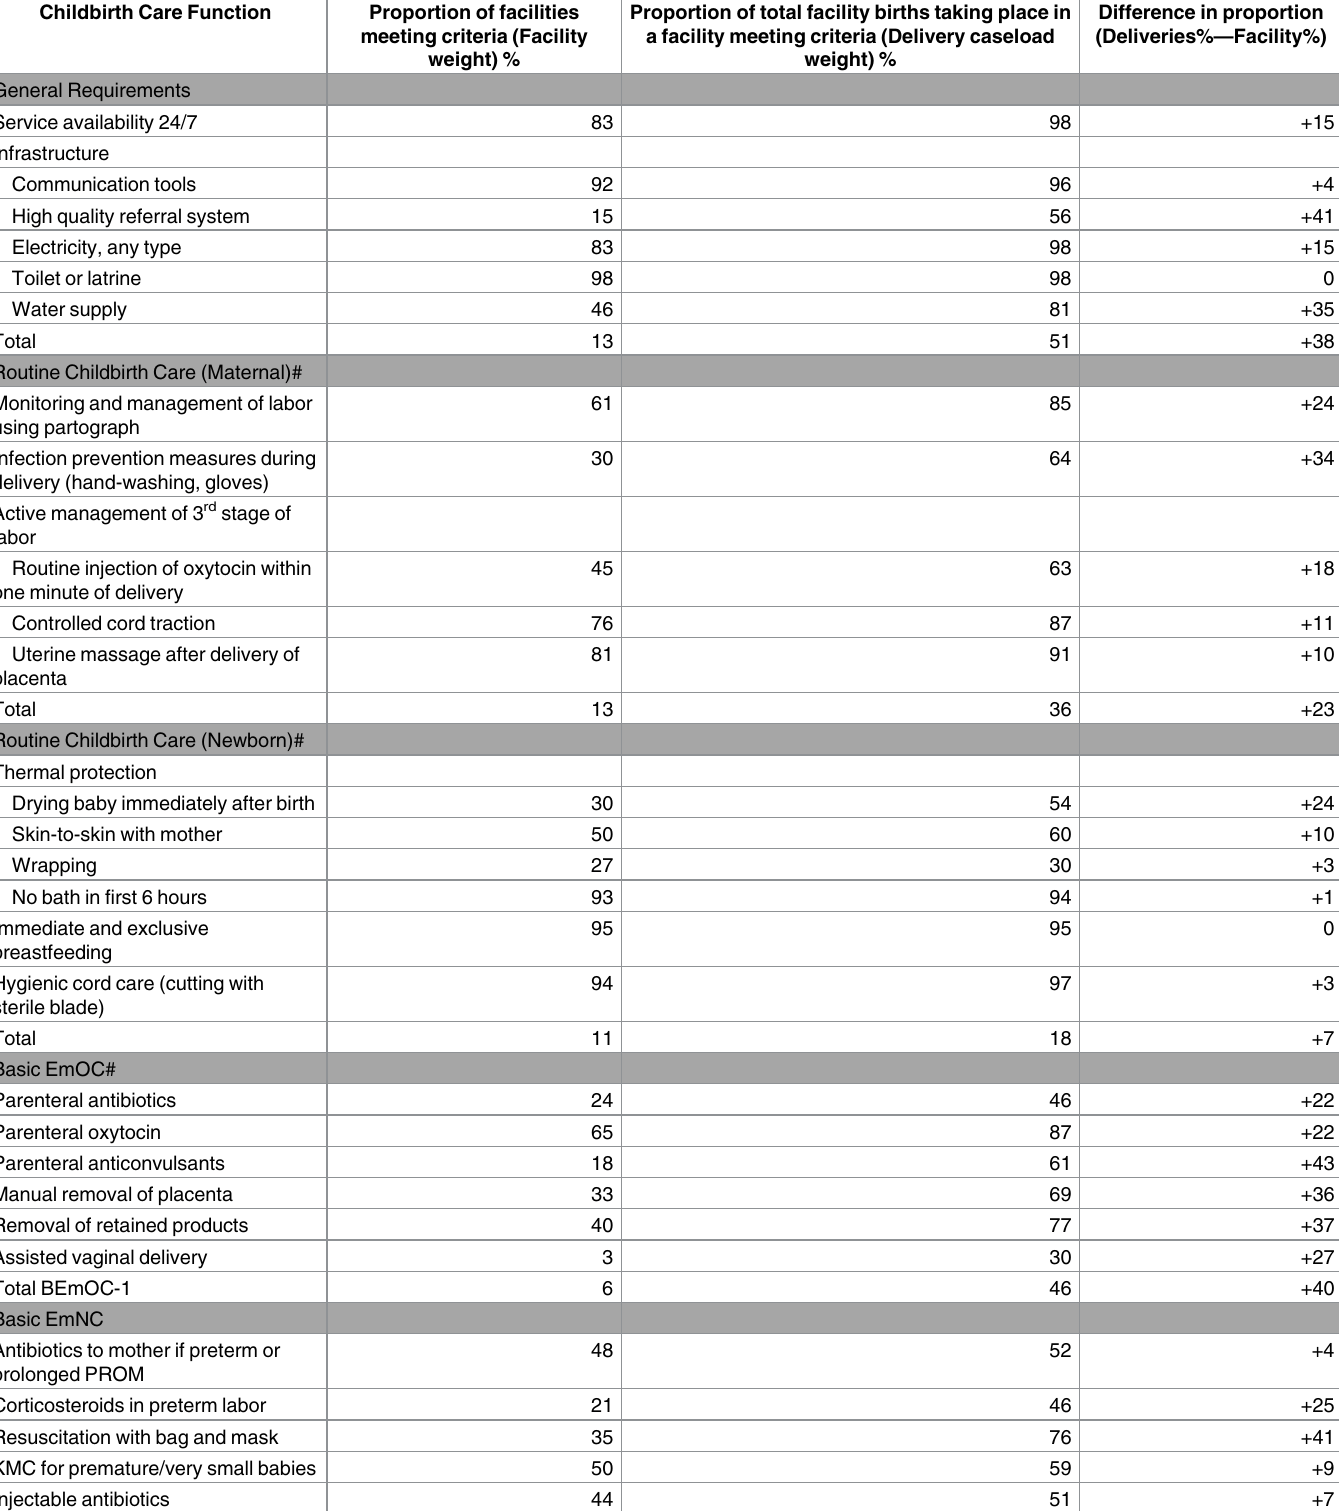
Table 6. Differencein facility preparedness, comparing facilities with births in facilities (delivery caseload weight